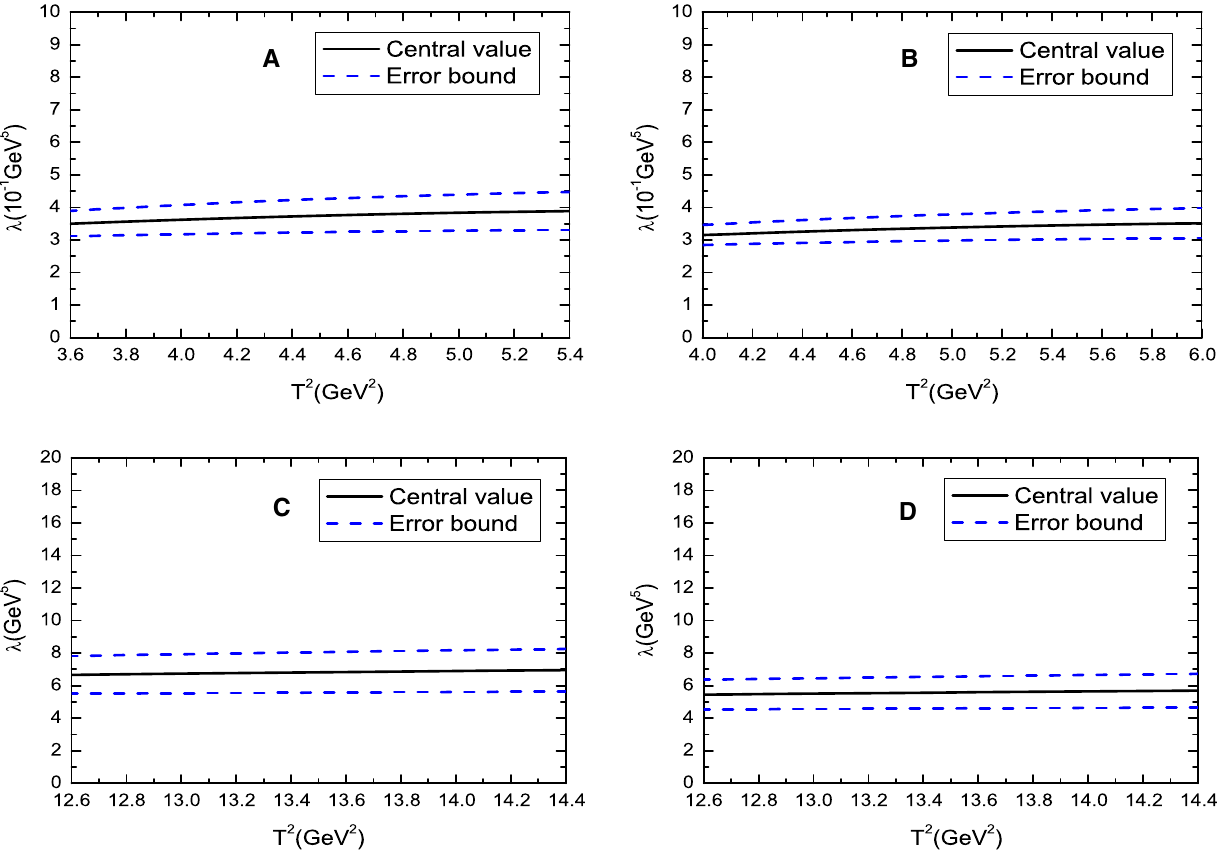
Fig. 4 The pole residues of the tetraquark states with variations of the Borel parameters T 2 , where A , B , C and D denote cc ¯ c ¯ c ( 0 ++ ) , cc ¯ c ¯ c ( 2 ++ ) , bb ¯ b ¯ b ( 0 ++ ) and bb ¯ b ¯ b ( 2 ++ ) ,